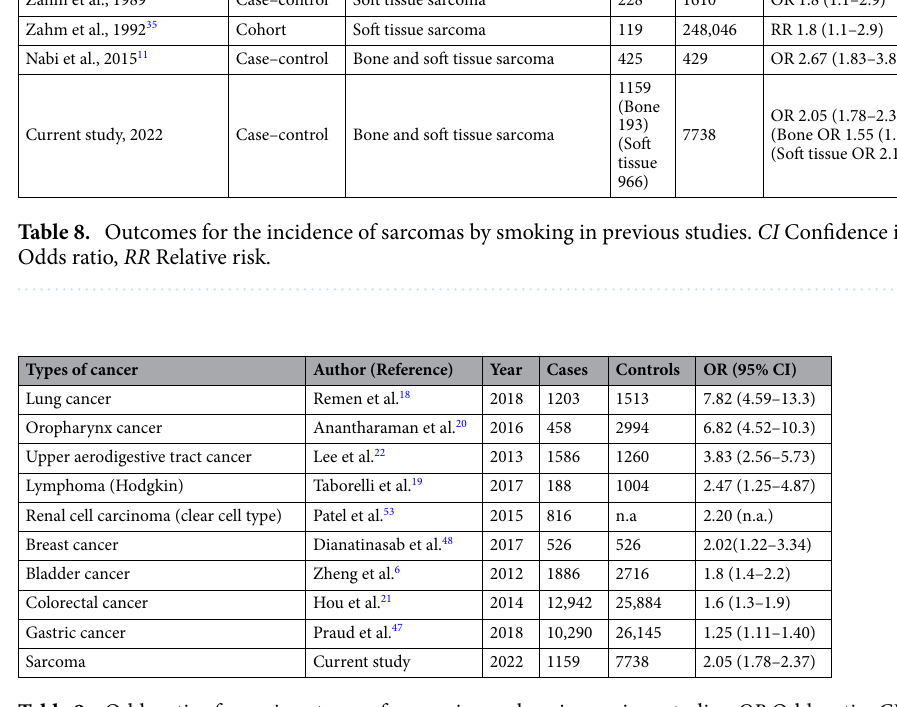
Table 9. Odds ratios for various types of cancer in smokers in previous studies. OR Odds ratio, CI Confidence